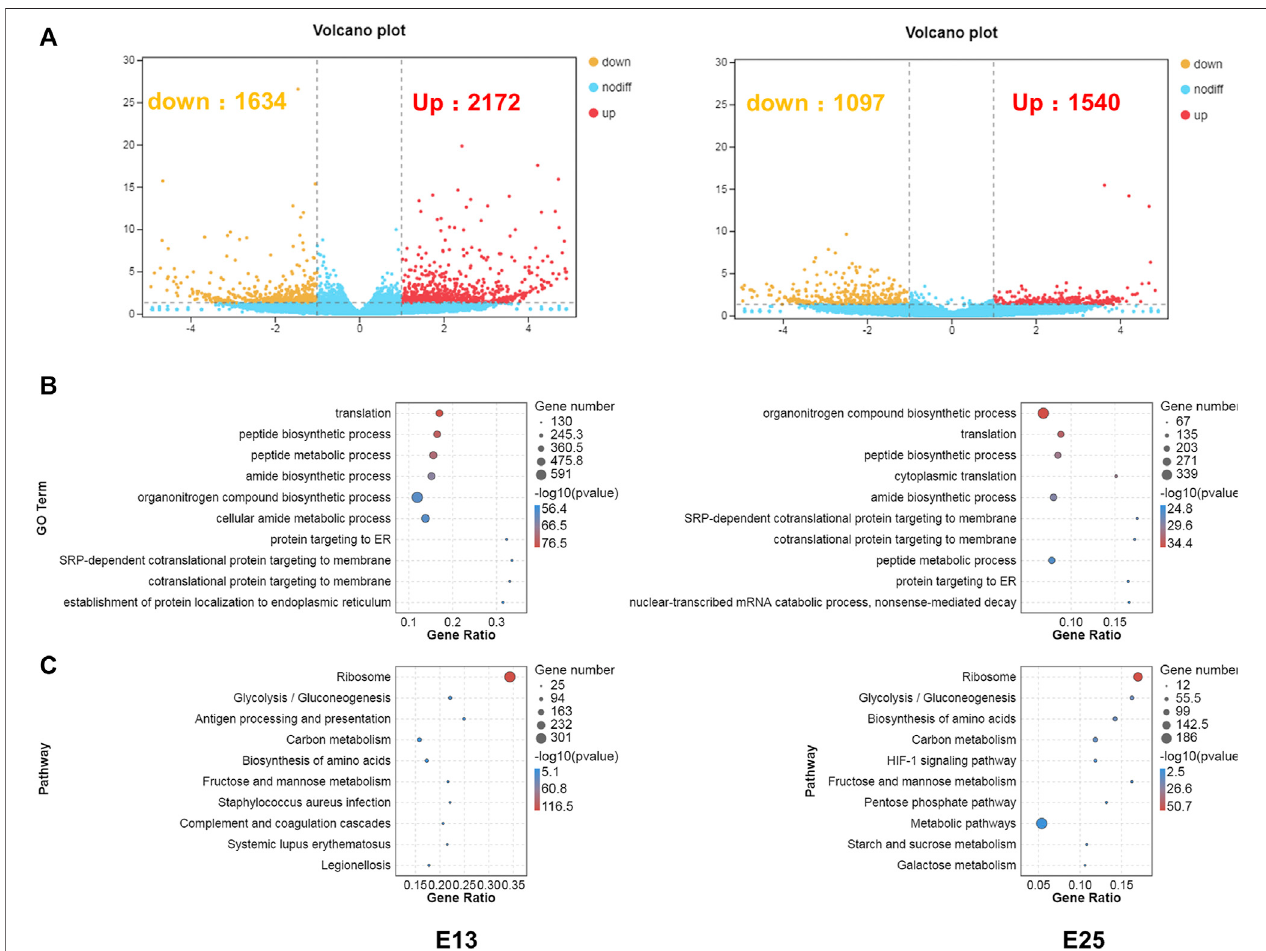
FIGURE7| DEGsareassociatedwithtranslation,metabolism,energytransport,andstress-relatedGOterms,andKEGGpathways. (A) VolcanoplotsoftheDEGs betweenCKand5,000 nggroups,respectively,atE13andE25. (B) GOenrichmentinbiologicalprocesscategoryoftheDEGsatE13andE25. (C) KEGGenrichmentof the DEGs at E13 and E25. n = 3